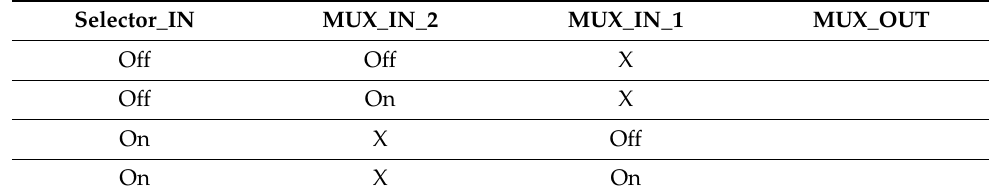
Table 2. Truth table for 2-to-1 Multiplexer.